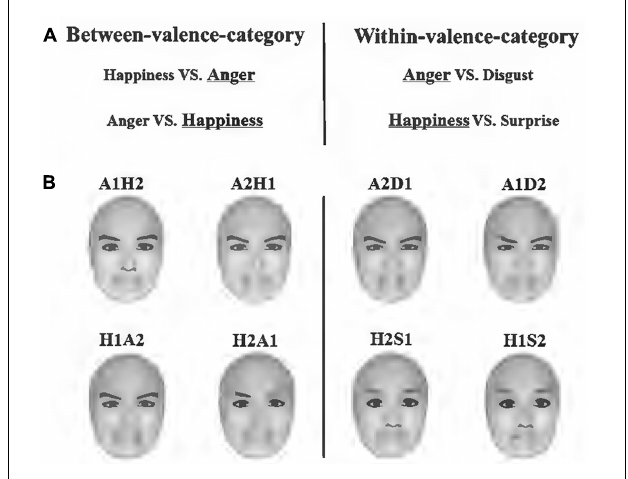
FIGURE 1 | Stimuli and conditions used in the study. (A) Emotional expressions chosen to create between-valence-category pairs and within-valence-category pairs. The underlined expressions were centers of different expression groups. (B) Illustration of morphed faces used in the experiment. Each face contained two kinds of emotional expressions, e.g., A1H2 was 1/3 anger combined with 2/3 happiness. Faces on the left side belonged to the between-category condition, and those on the right side belonged to the within-category condition. FIGURE 2 | Mean reaction time and accuracy under different